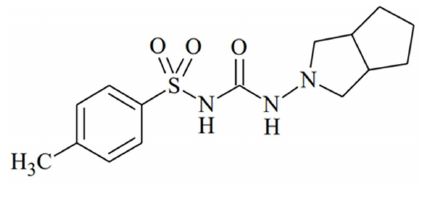
Figure 1. Gliclazide Chemical Structure.